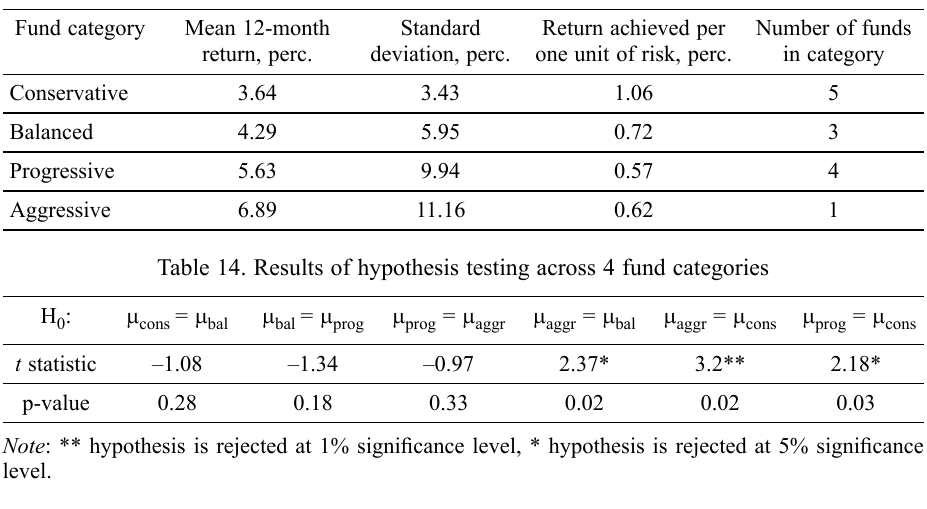
one unit of risk, perc.